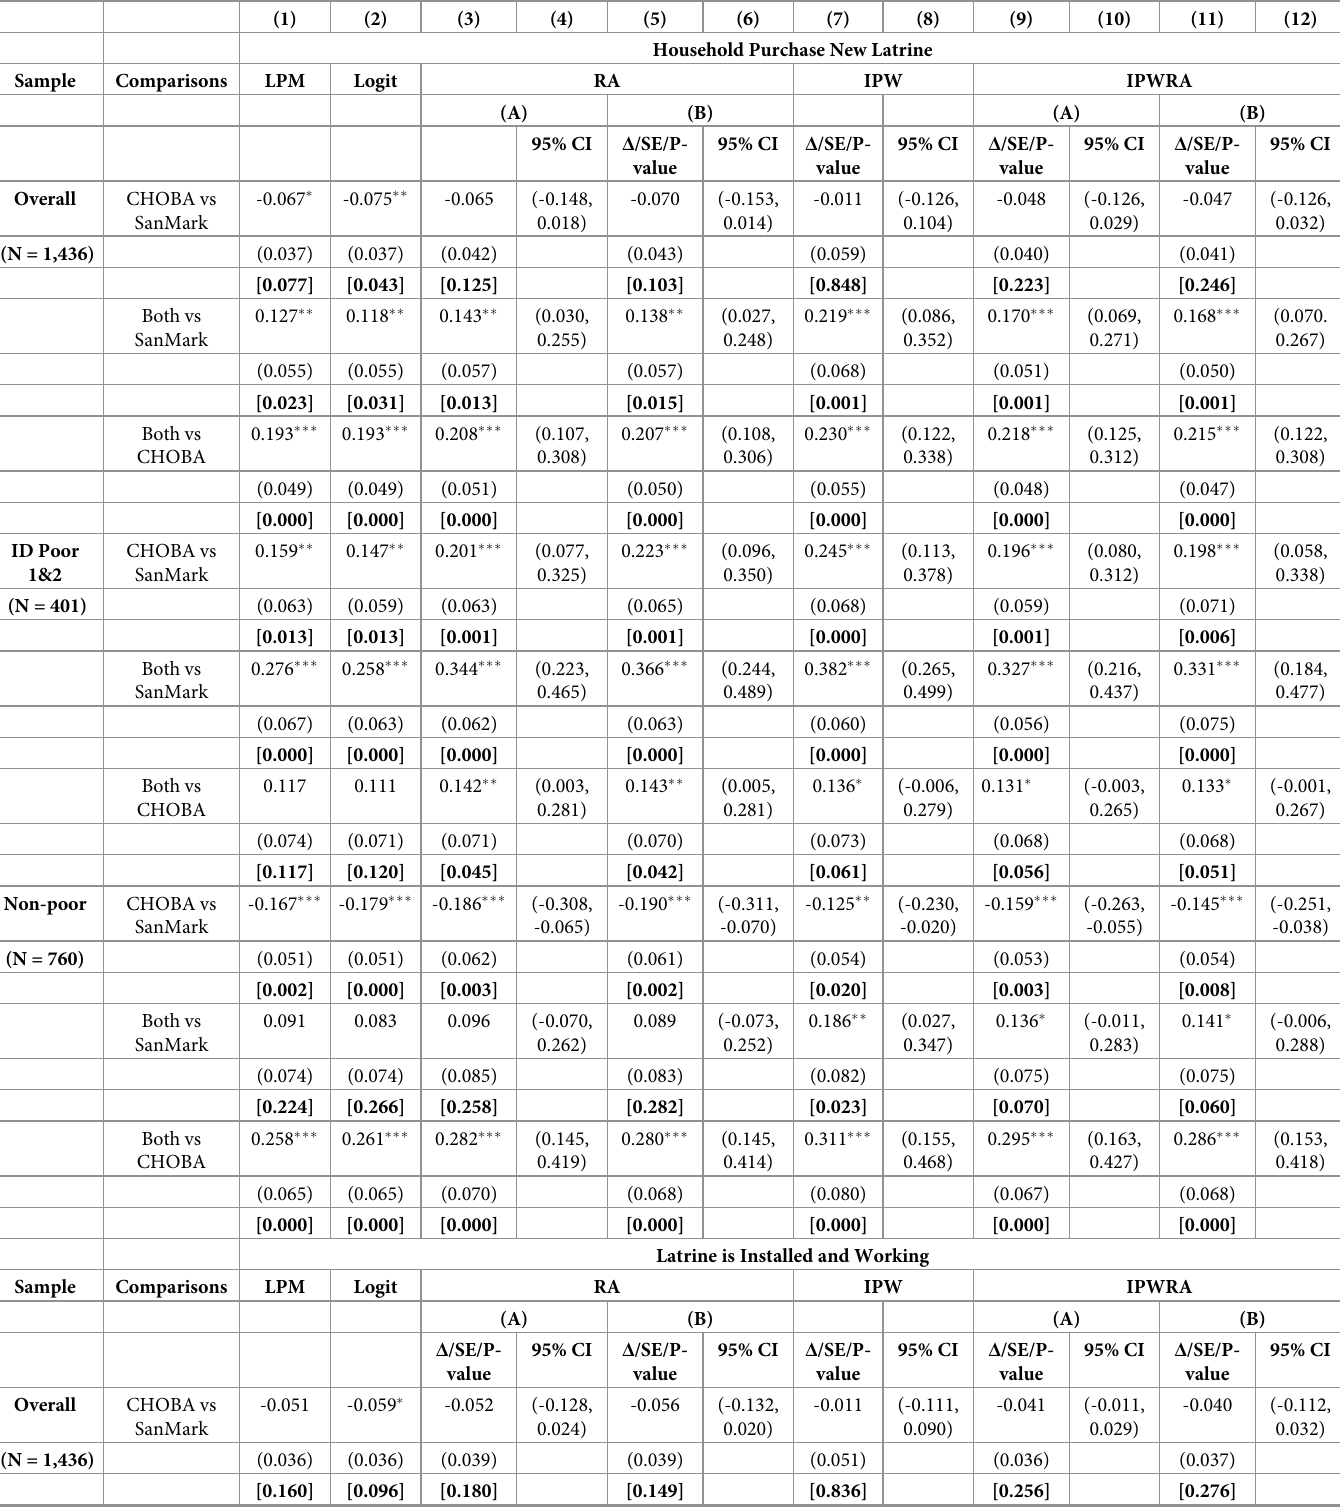
Table 6. Estimated Average Treatment of the Treated (ATT) of village programs on latrine purchasing and installation by RA, IPW and